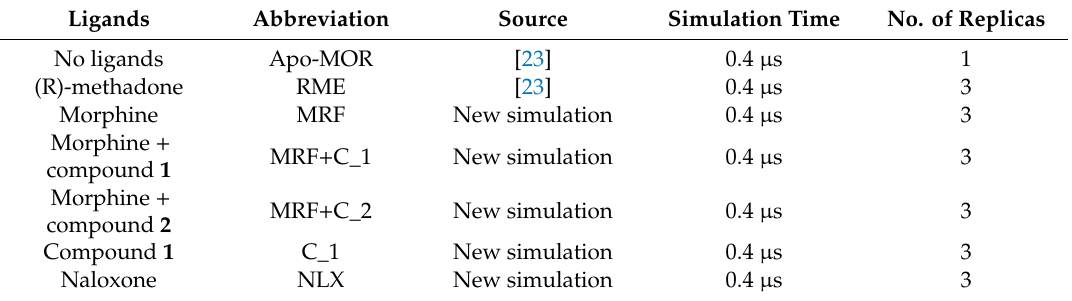
Table 1. Summary of trajectories from all-atom, unbiased molecular dynamics simulations analyzed in this